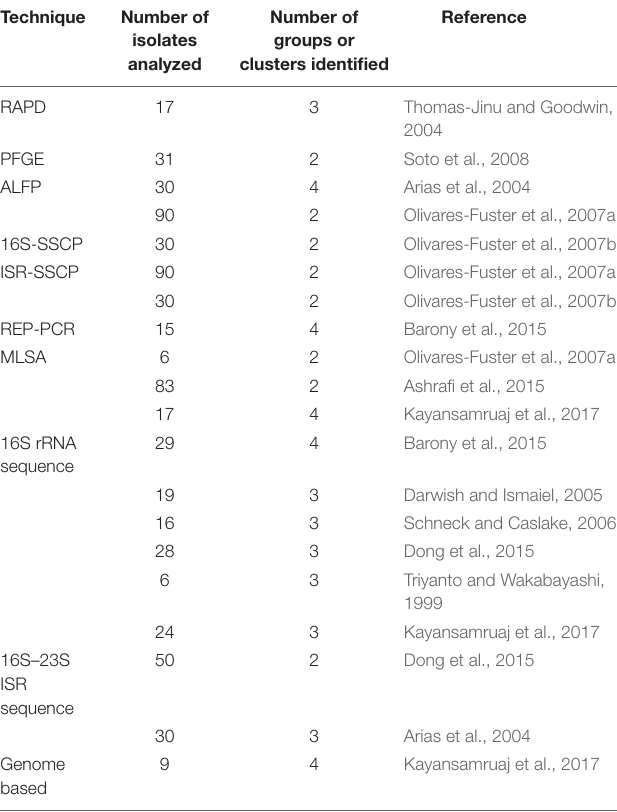
TABLE 1 | Summary of publications that used molecular approaches to define the genetic diversity of Flavobacterium columnare .